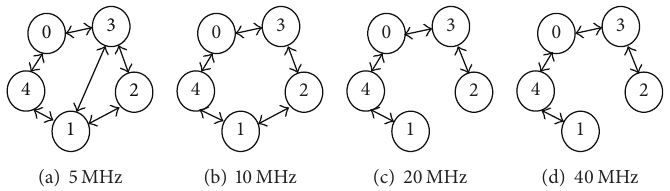
Figure 9: The network topology of adopting the channel width of (a) 5 MHz, (b) 10MHz, (c) 20 MHz, and (d) 40 MHz.